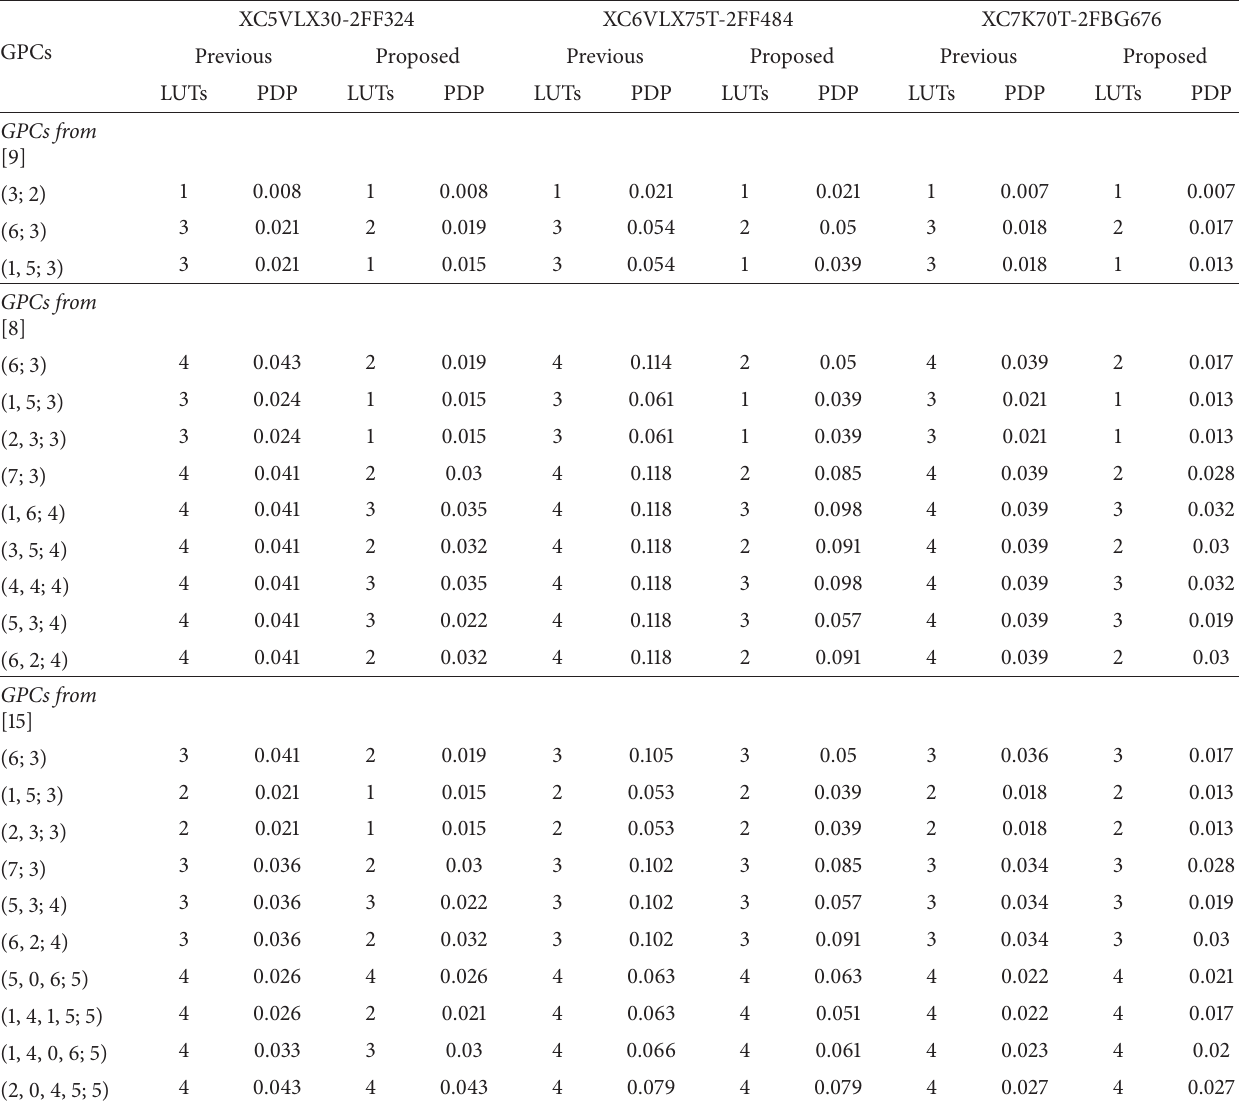
Table 2: Performance comparison of different GPCs on XC5VLX30-2FF324.